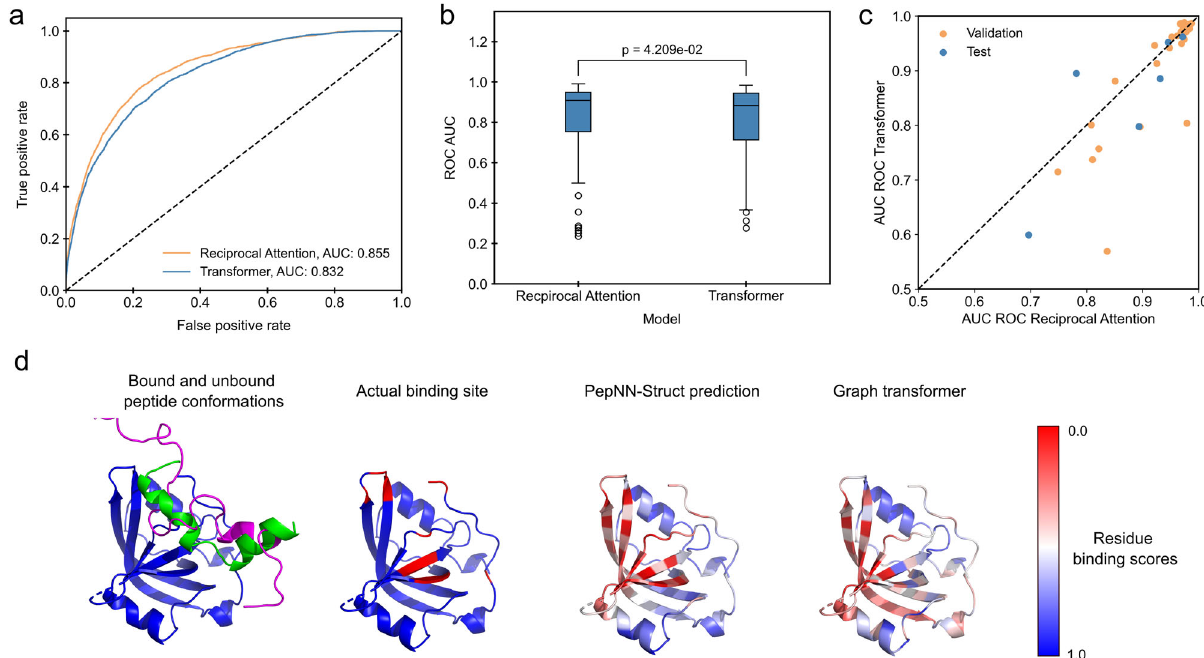
Fig. 3 Comparison of PepNN-Struct and a Graph Transformer. a ROC curves on all residues in the TS092 dataset. b Comparison of distribution of ROC AUCs on different input proteins (Wilcoxon signed-rank test, n = 92 protein-peptide complexes). c Comparison of model performance on examples where bound peptides undergo conformational changes. d Prediction of the binding site of a P53 N-terminal peptide to RPA70N (PDB Code 2B3G). Unbound peptide conformation is shown in magenta (PDB Code 2LY4). Boxplot centerlines show medians, box limits show upper and lower quartiles, whiskers are 1.5 the interquartile range and points show